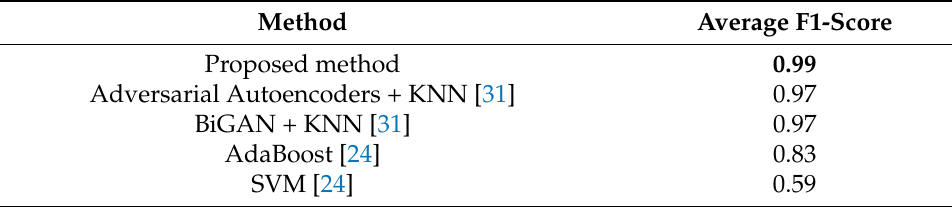
Table 5. Comparison of